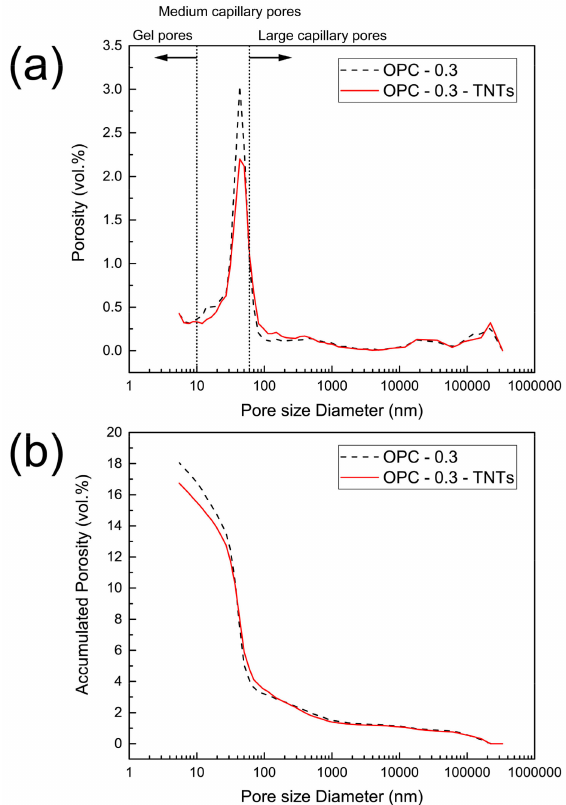
Figure 12. MIP results of ordinary Portland cement paste with TNTs, ( a ) pore size distribution, and ( b ) total